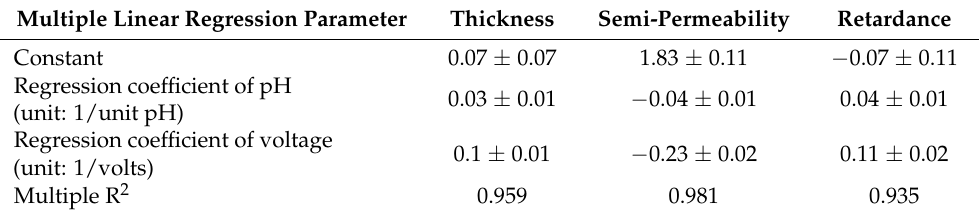
Table 2. Summary of multiple linear regression analysis of the electrofabricated chitosan membrane properties (e.g., thickness, semi-permeability, and retardance) as functions of pH and voltage. The table summarizes the linear regression coefficients of specific membrane properties in relation to the alginate pH and voltage with coefficients expressed as unstandardized coefficient ± standard